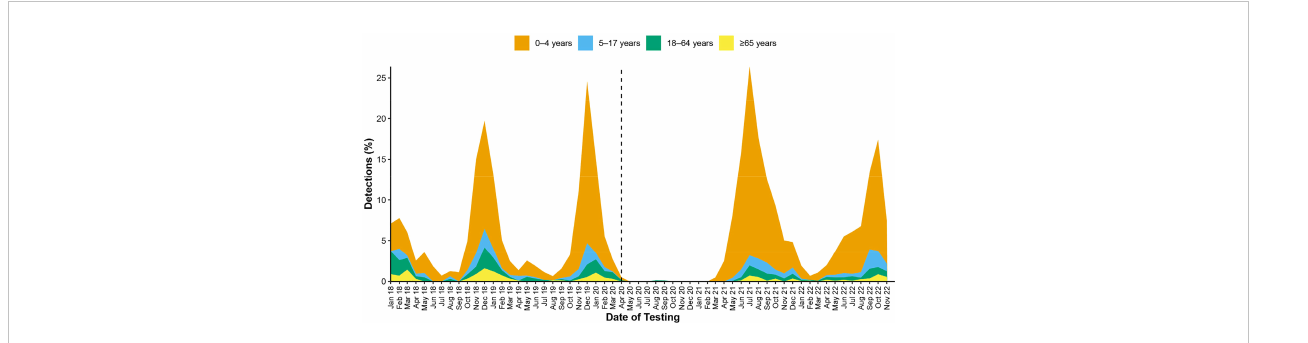
FIGURE 1 Monthly proportions of respiratory pathogen panels positive for respiratory syncytial virus in Nashville, Tennessee, before and during the COVID-19 pandemic (January 2018 to November 2022). The dashed line represents the fi rst day Tennessee ’ s stay-at-home order was in effect.